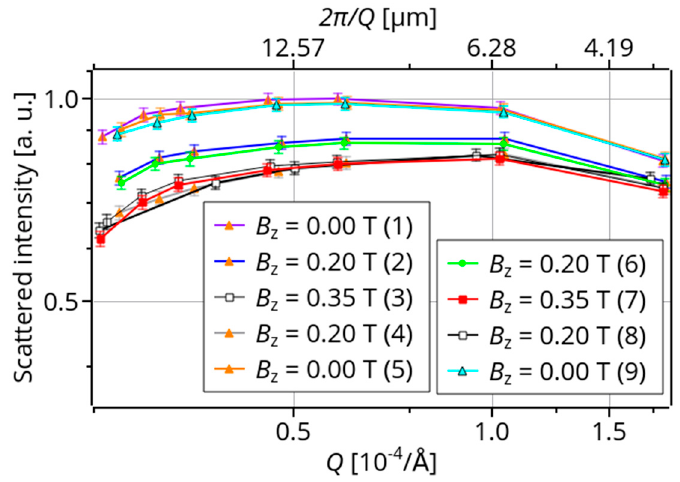
Figure 5. USANS curves of the MAE sample with 80 mass% of Fe and a soft matrix for different magnetic fields.